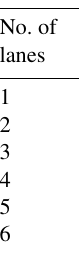
Table B6. Assumed road width when in OSM the number of lanes is